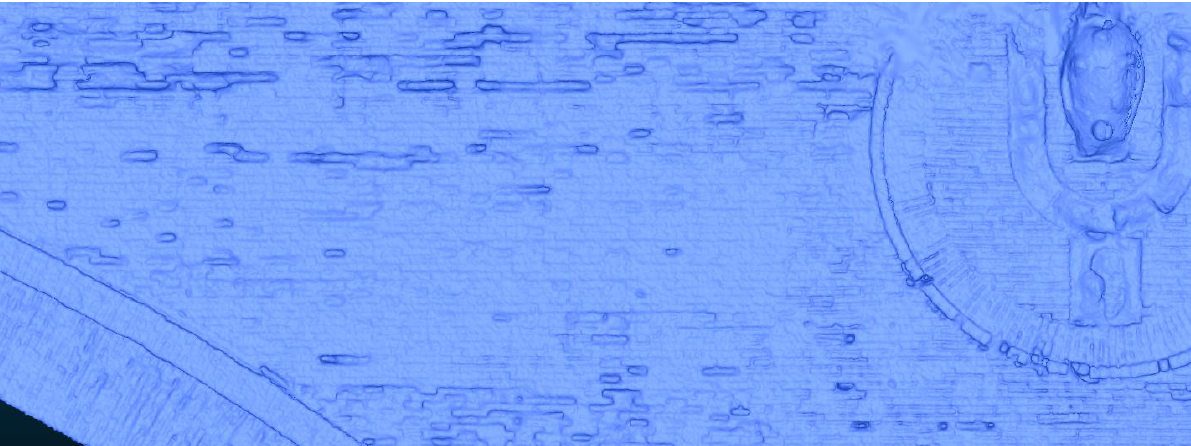
Figure 5 – Particular of the 3D mesh. Red square in figure 6.